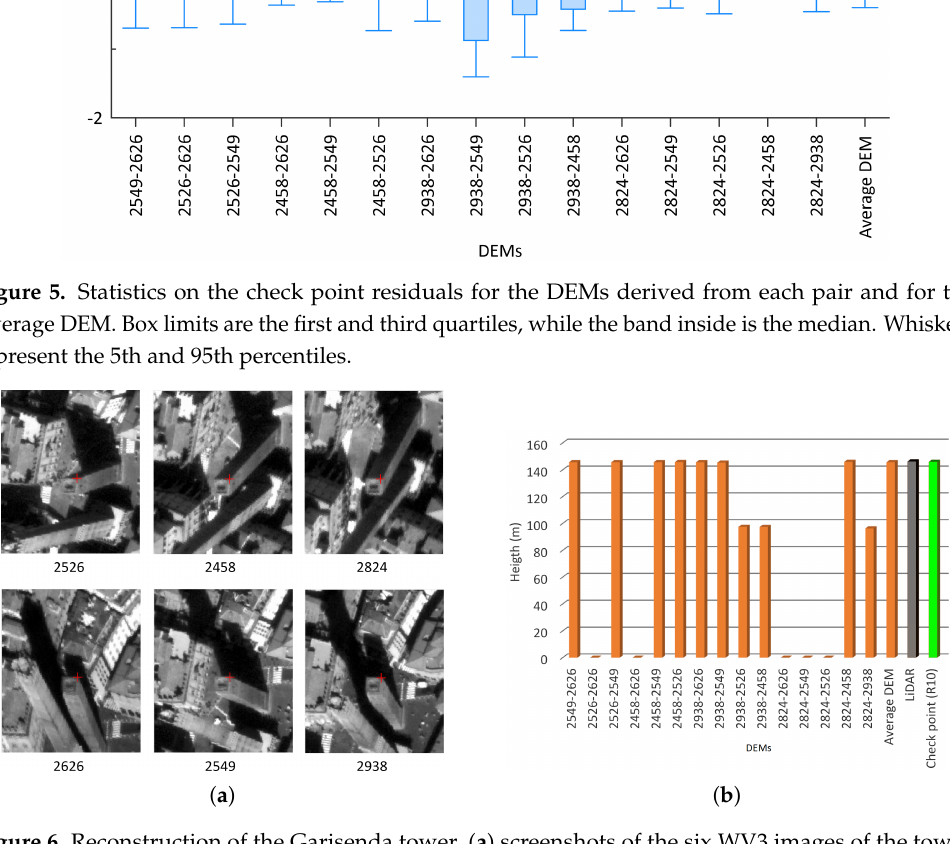
Figure 6. Reconstruction of the Garisenda tower. ( a ) screenshots of the six WV3 images of the tower; ( b ) computed heights of the tower according to the WV3 DEMs and reference data. Table 3. Statistics on the M3C2 distance (in metres) computed between the WV3 Average DEM and the reference data in the three